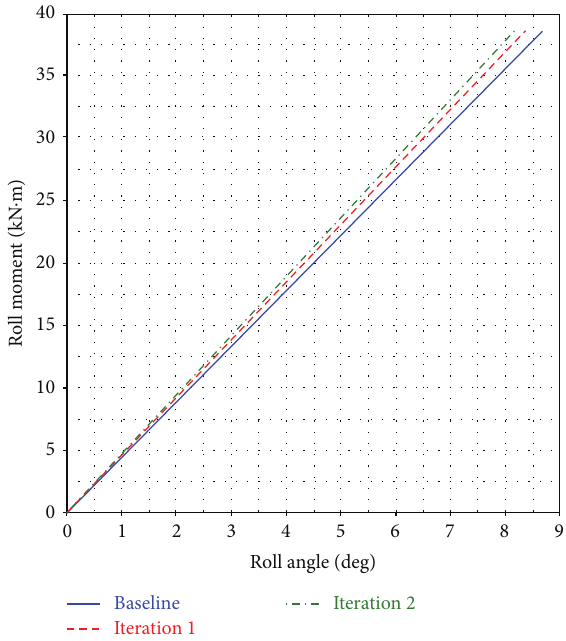
Figure 9: Graph of roll moment versus roll angle. stiffness, the parabolic leaf spring in Iteration 2